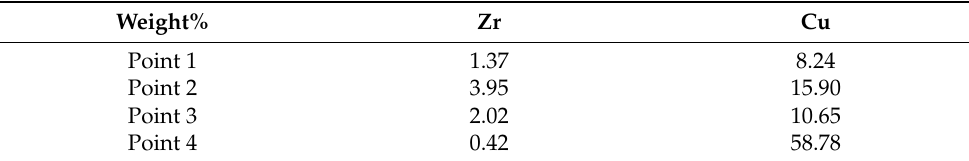
Figure 3. SEM micrograph of the machined surface for Ip = 5 A and Ton = 12.8 μ s.